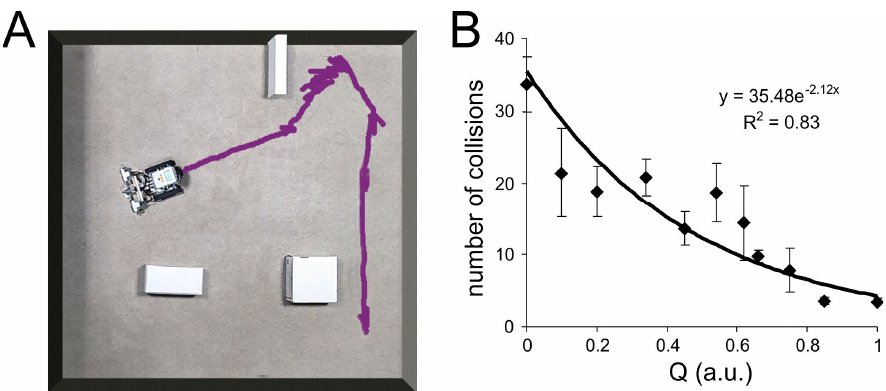
Figure 8. Testing the robot’s performance. ( A ) The experimental arena. The robot’s trace is shown in purple. Obstacles are in white. ( B ) The number of collisions with obstacles vs. the learning quality Q .